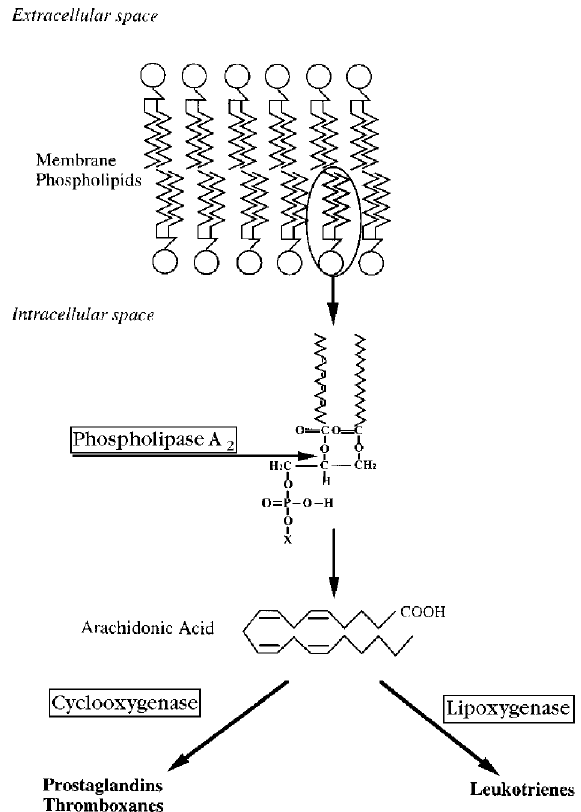
FIG. 1. The lipid mediator